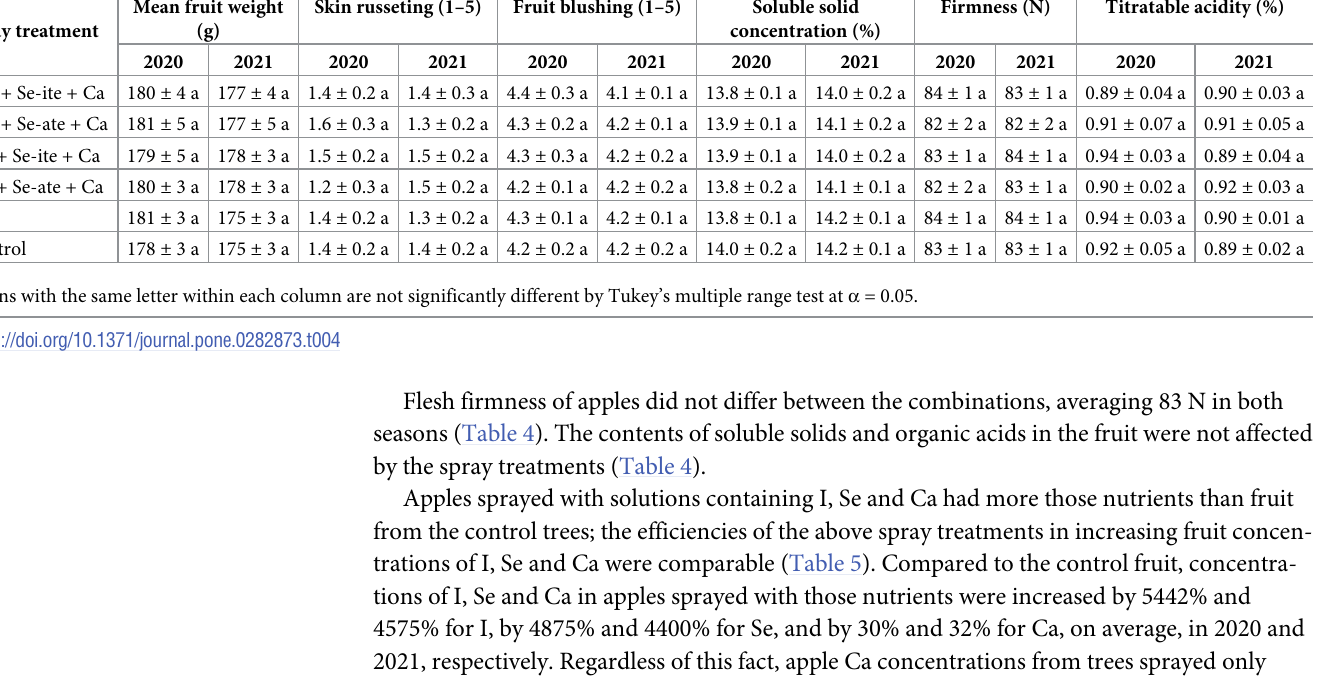
Table 4. Effects of combined sprays of iodine (I), selenium (Se) and calcium (Ca) on ‘Red Jonaprince’ apple quality at harvest. Mean fruit weight Spray treatment (g)